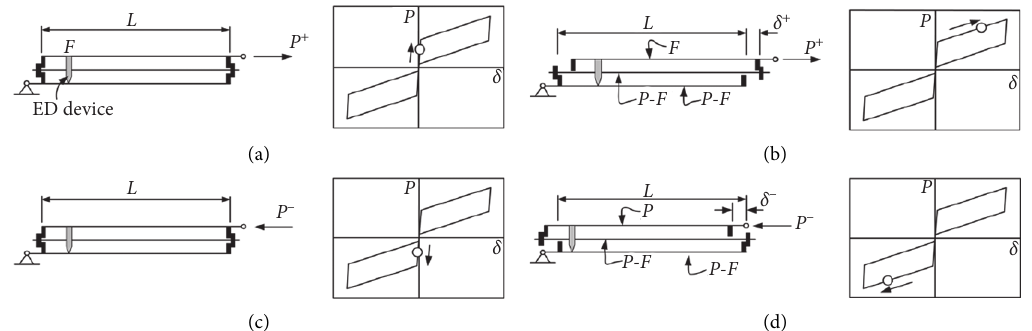
Figure 3: Mechanics and hysteretic response of self-centering bracing system (adapted from [5]).